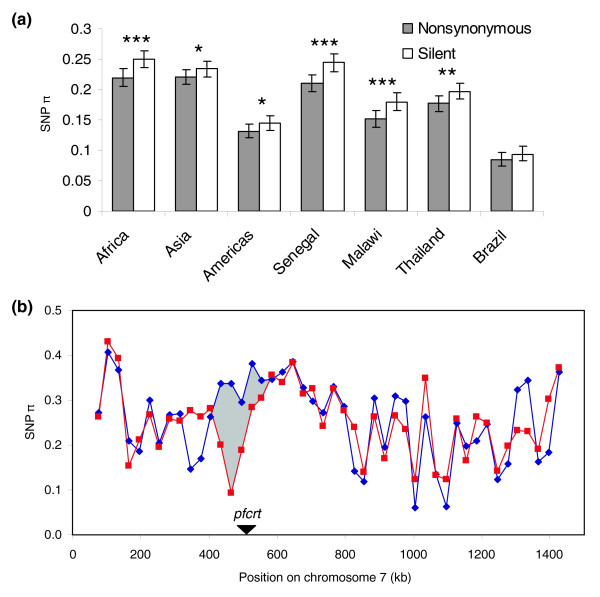
Diversity at assayed SNPs (SNP π). (a) Nonsynonymous and silent SNP diversity by population. Significantly lower nonsynonymous SNP diversity (determined by bootstrapping) is indicated by asterisks: *P < 0.05; **P < 0.001; ***P < 0.0001. Error bars indicate 95% confidence intervals derived from bootstrapping. (b) SNP π on chromosome 7 for chloroquine resistant (red) and chloroquine sensitive (blue) samples. The disparity in diversity near 460 kb indicated with gray shading likely corresponds to a selective sweep associated with the pfcrt locus.